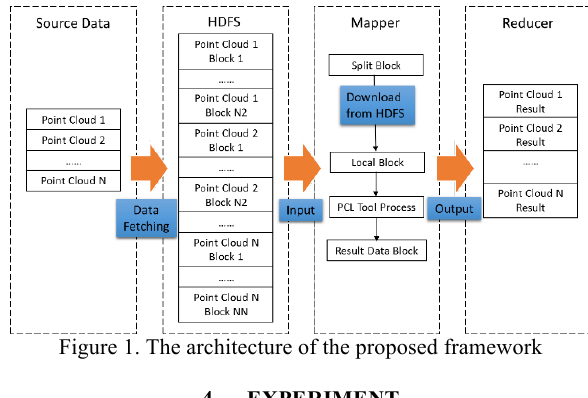
Figure 1. The architecture of the proposed framework 4.